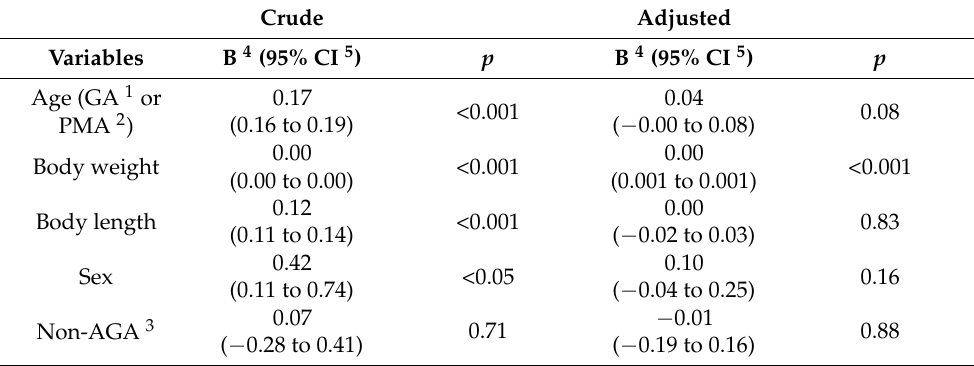
Table 4. Multivariable linear regression for factors associated with final endotracheal tube depth in